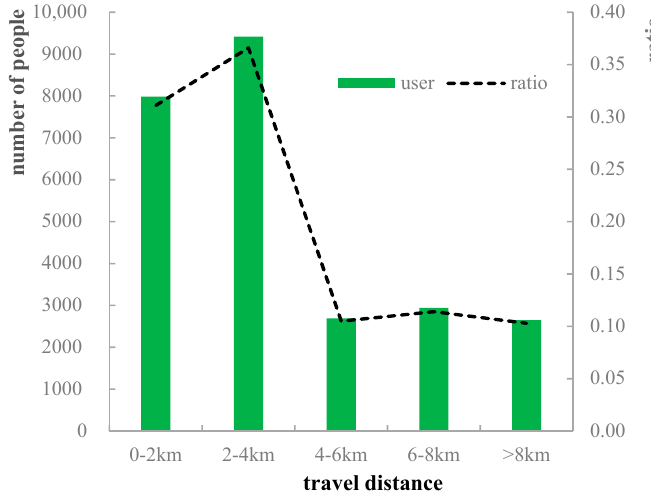
Figure 6. Travel distance and ratio.